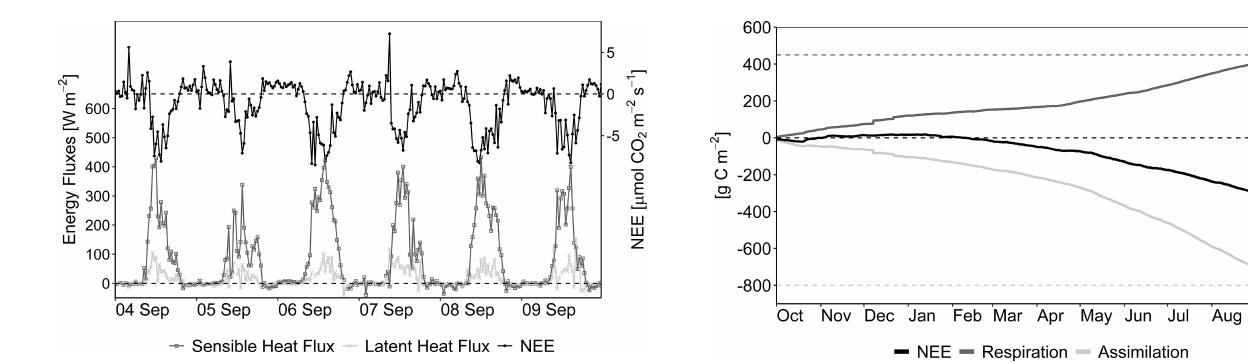
Figure 13. Cumulative NEE, assimilation and respiration fluxes 2017 to 30 September